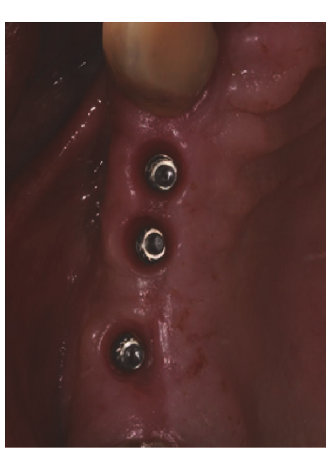
Figure 13: Rx control post-op.